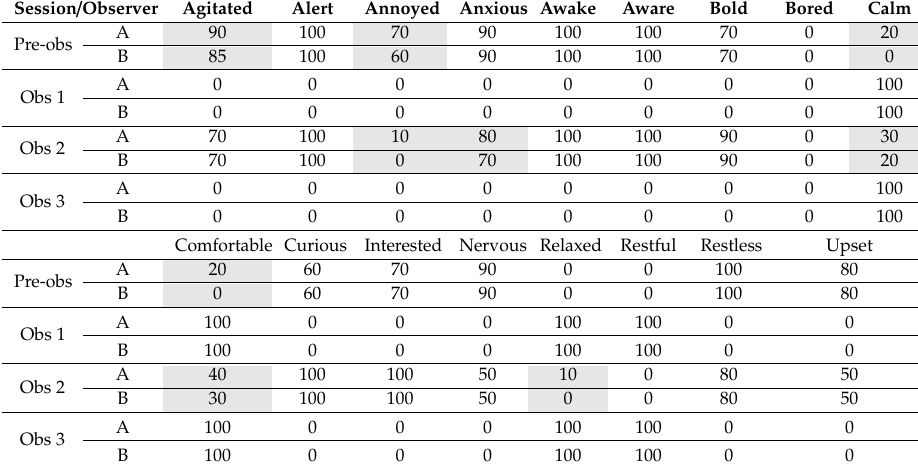
Table 2. Example of personality scoring for an individual swan. The bird’s personality was scored from 0 (not describing the bird’s behavioural expression at all) to 100 (completely describing the bird’s behavioural expression). Cells in light grey indicate those where observers did not agree.